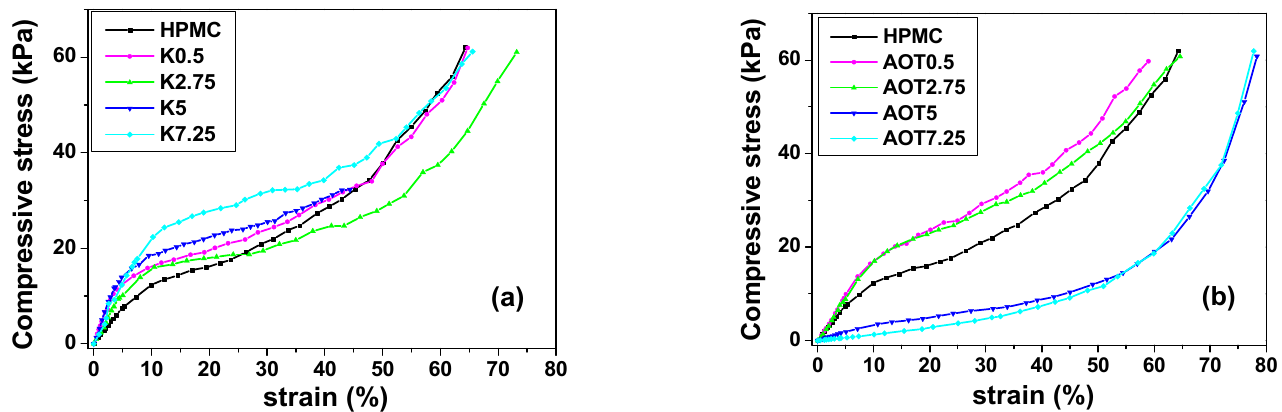
Figure 1. Compressive tests of cryogels containing ( a ) Kolliphor ® EL and ( b ) AOT under the strain rate of 0.010 s − 1 at 23.7 ± 0.7 °C and a relative air humidity of 61 ± 4%, n = 10.